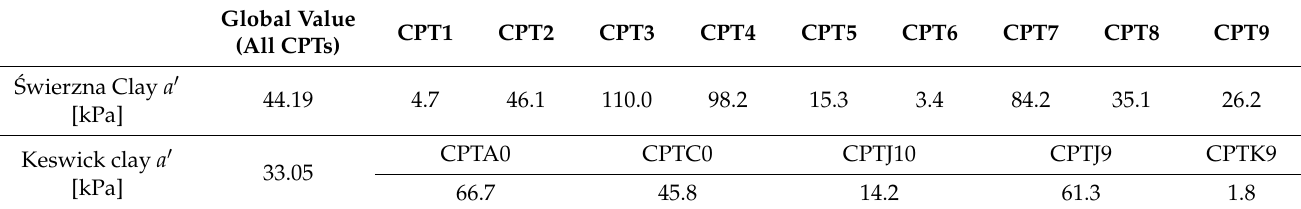
Table 5. a (cid:48) values for the considered sections of CPT